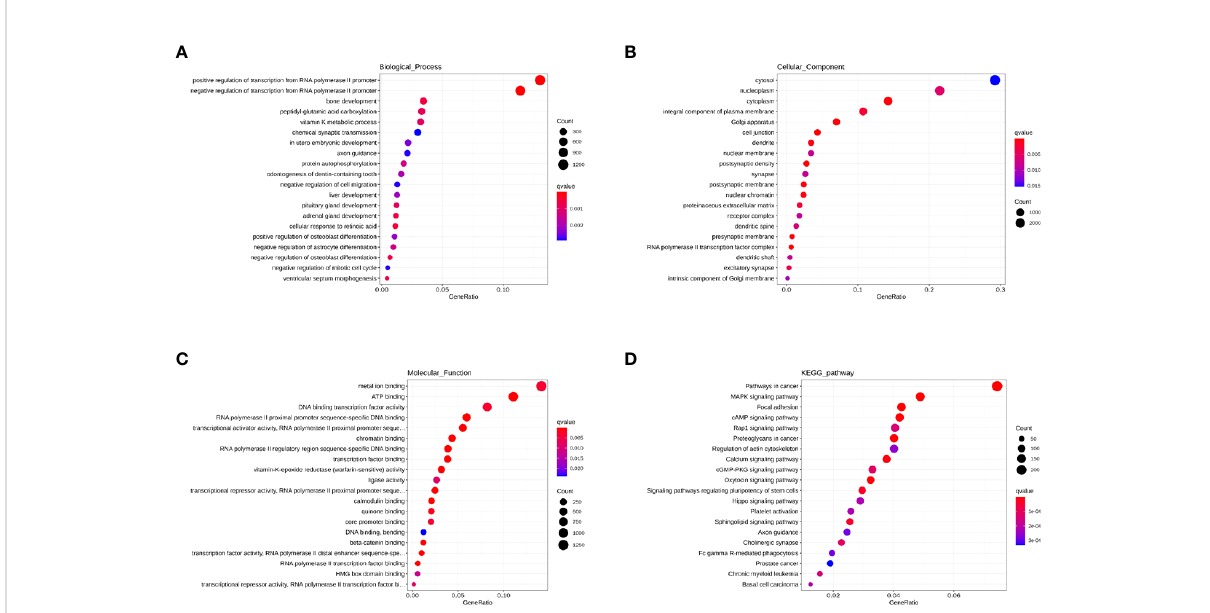
FIGURE 7 The GO and KEGG enrichment analysis interpretation for the functions for the blue module. (A – C) The GO terms interpretation for the functions of these 208 differential miRNAs. (D) The KEGG terms interpretation for the functions of these 208 differential